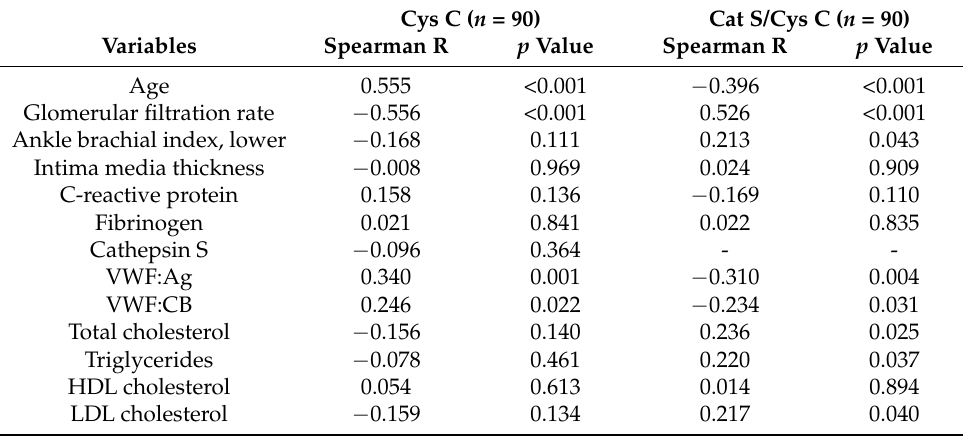
Table 2. Correlations of Cys C and of the Cat S/CysC ratio in the overall group.